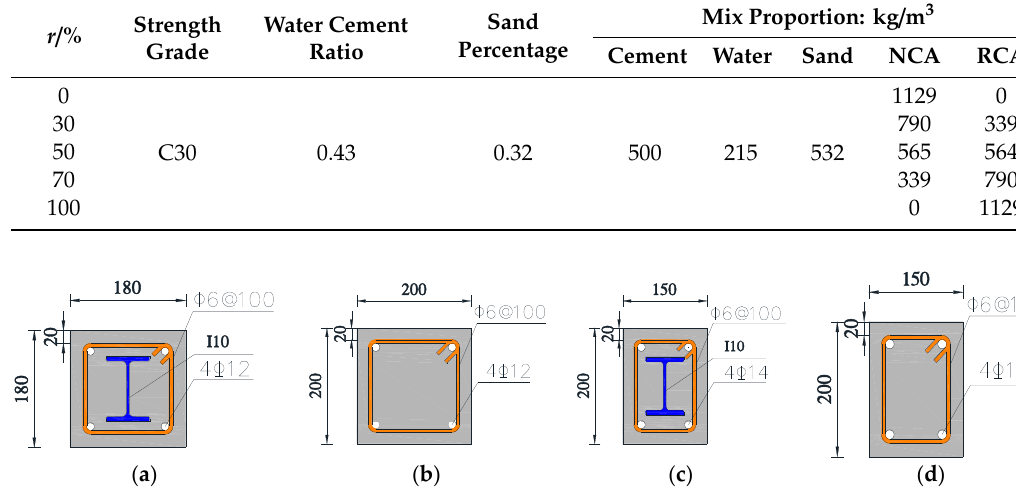
Figure 1. Section size and steel forms of specimens (mm). ( a ) SRRAC column; ( b ) RRAC column; ( c ) SRRAC beam; ( d ) RRAC beam. Table 1. Mix proportion of recycled concrete.